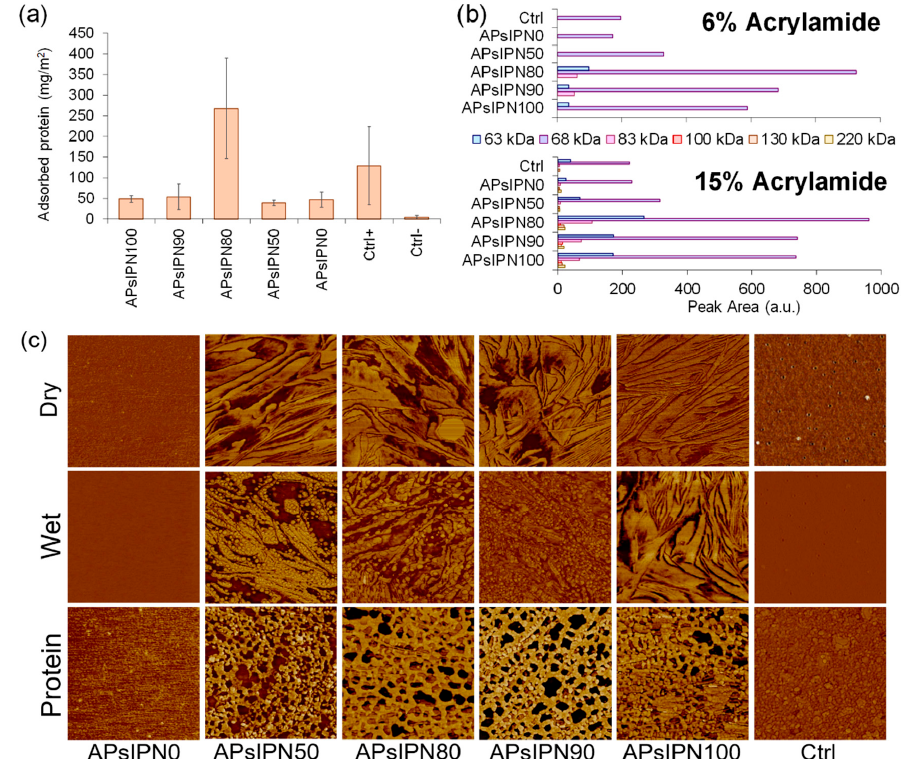
Figure 2. Serum protein adsorption on APsIPN substrates. ( a ) Adsorbed serum protein per area, as measured from the adapted Micro BCA assay; ( b ) Greyscale band quantification of stained SDS–PAGE acrylamide gels (6 and 15 wt %) for detached proteins. Significant bands are indicated as their corresponding molecular mass; ( c ) Phase-contrast atomic force microscope (AFM) images of the array of APsIPN substrates and control (glass coverslip) in dry conditions (top), after a 30-min immersion in water (middle) and after incubation with 10% fetal bovine serum (FBS) (bottom). All samples were sprayed with distilled water and dried with argon prior to observation. Images are 1 μ m side squares, normalized to ( − 30°, 30°) phase range.